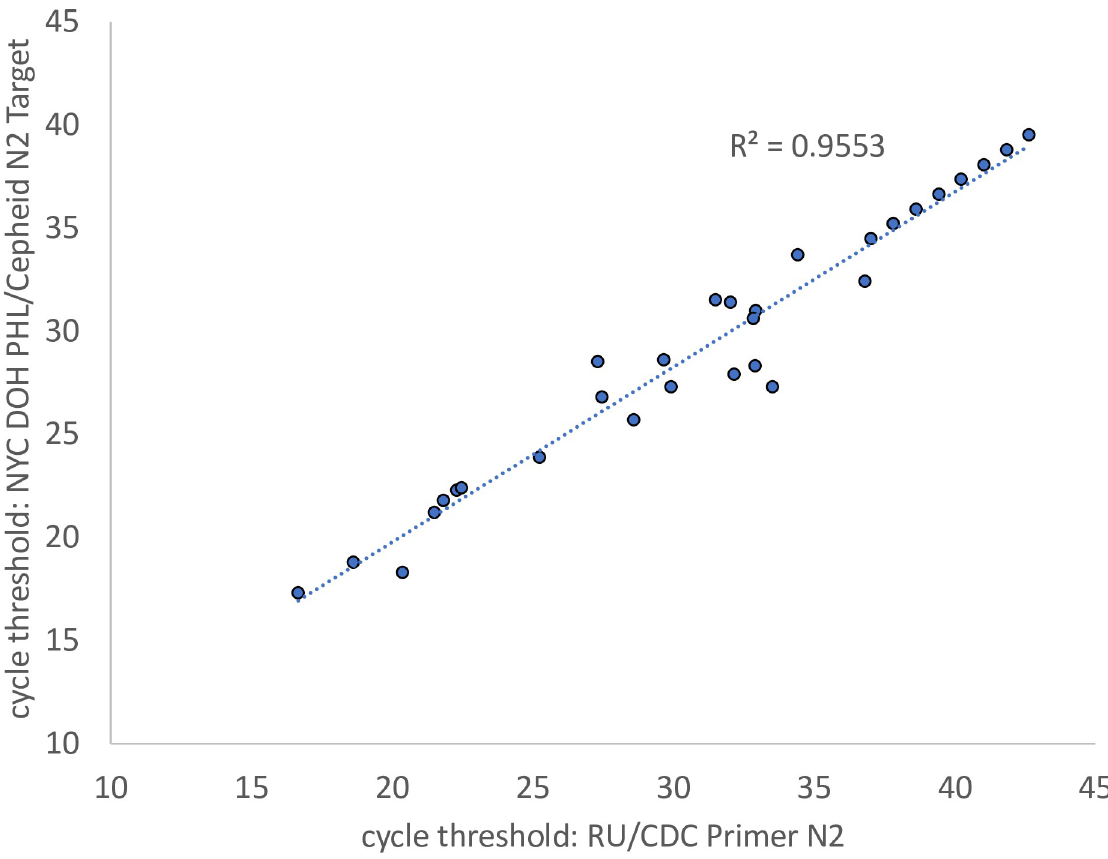
Fig 3. Correlation of NP samples on Cepheid Xpert Xpress SARS-Cov-2 platform versus phenol extraction in DRUL buffer.